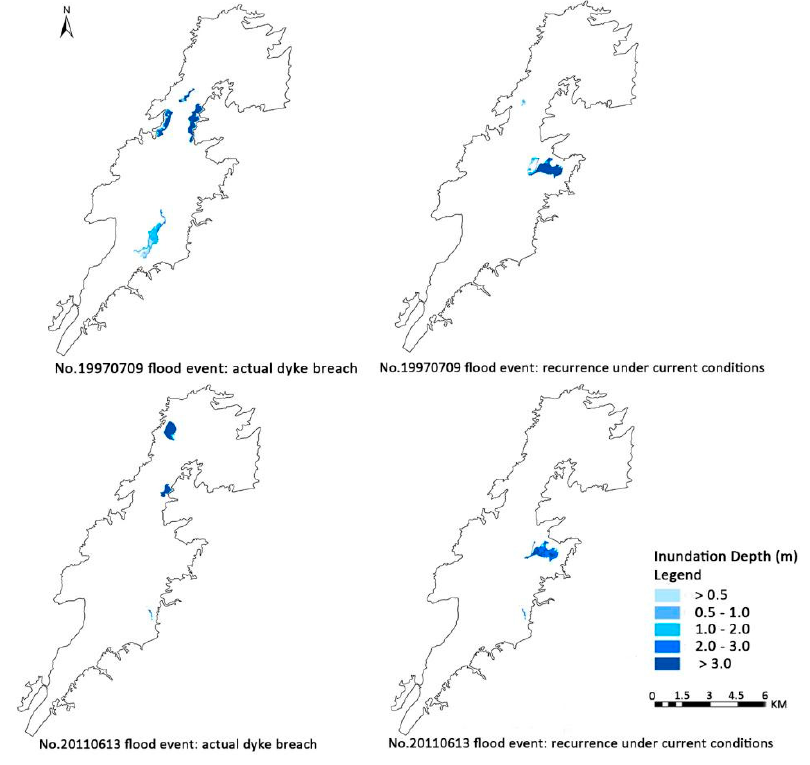
Figure 7. Inundation maps of the historical scenario. Table 9. Flood simulation results comparison between the historical and current situations.